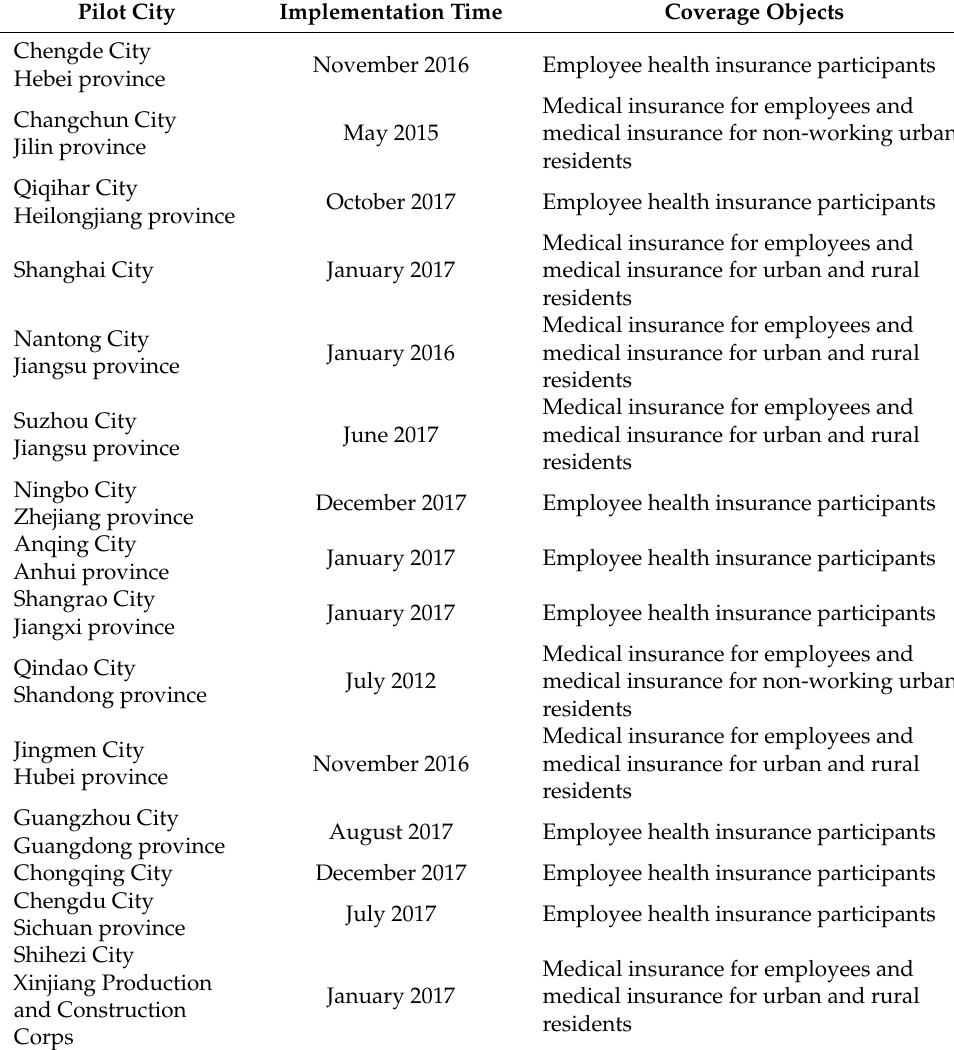
Table 1. Implementation time and coverage objects of the LTCI pilot program in 15 pilot